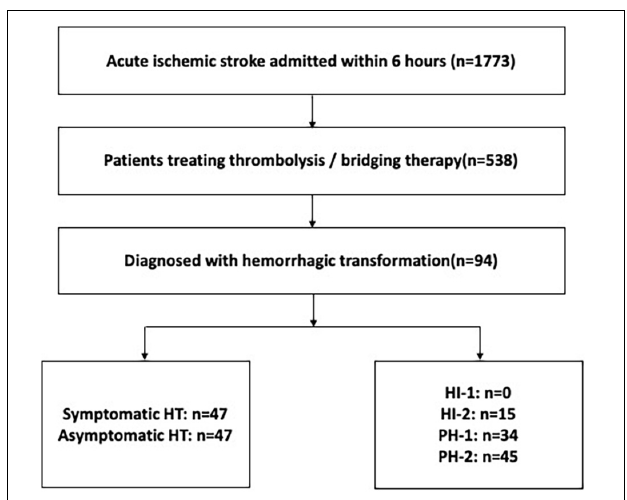
FIGURE 1 | The flowchart of patients. HT, hemorrhagic transformation; HI, hemorrhagic infarction; PH, parenchymal hematoma.